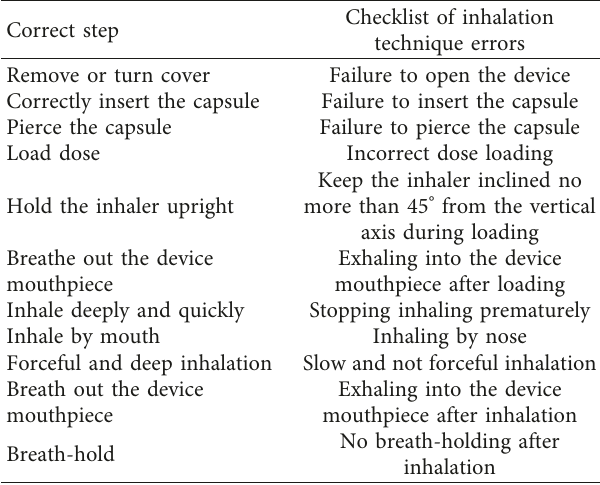
Table 2: DPI checklist of the proper inhalation technique and